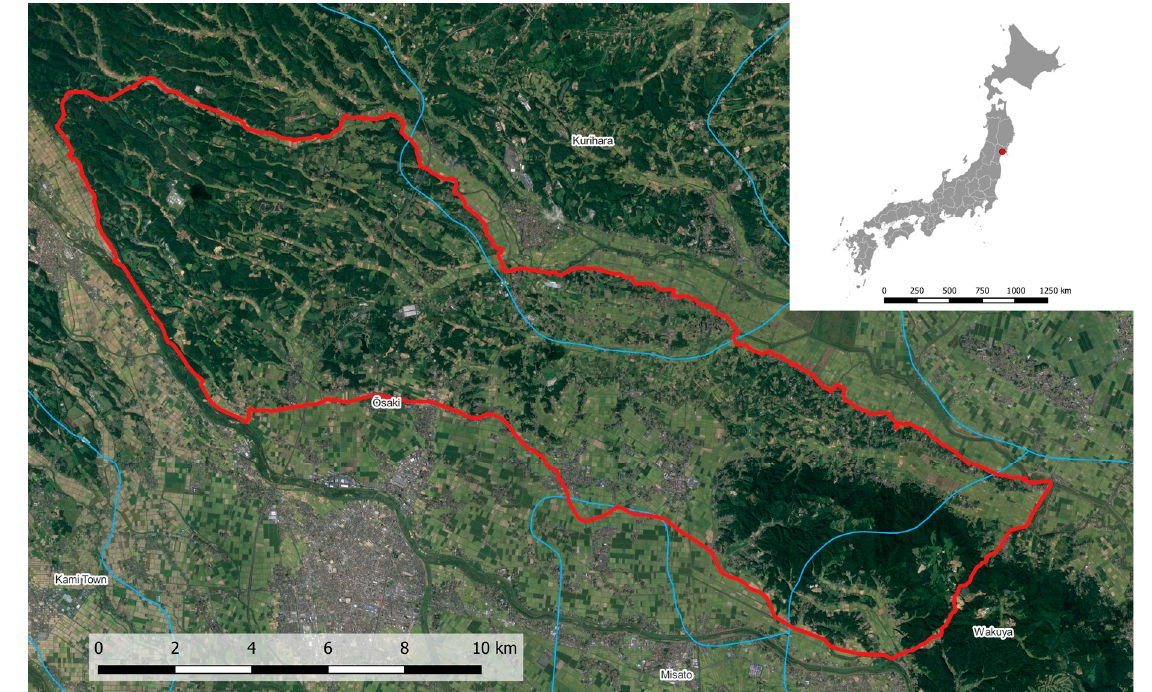
Figure 1. The study area (red border) corresponds to the main part of the GIAHS site called Osaki Kodo’s Traditional Water Management System for Sustainable Paddy Agriculture, and is located across the territories of Osaki, Kurihara, and Wakuya cities (light blue borders), in Miyagi Prefecture, Japan. It is possible to clearly observe the two big forest nodes in the north-west and south-east part of the study area.